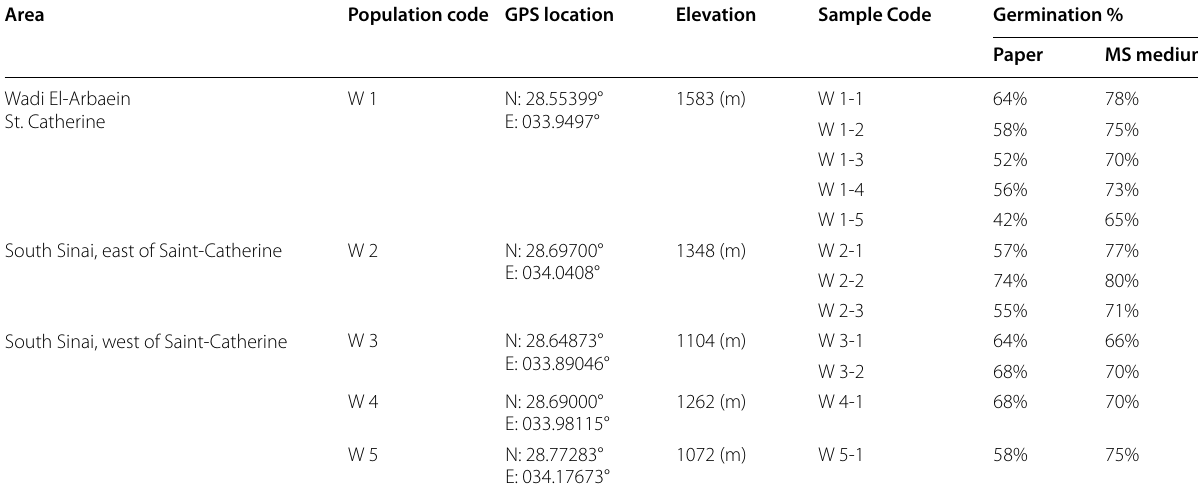
Table 1 The area, site, GPS location, number of samples and elevation of localities from which the examined A. fragrantissima accessions were collected